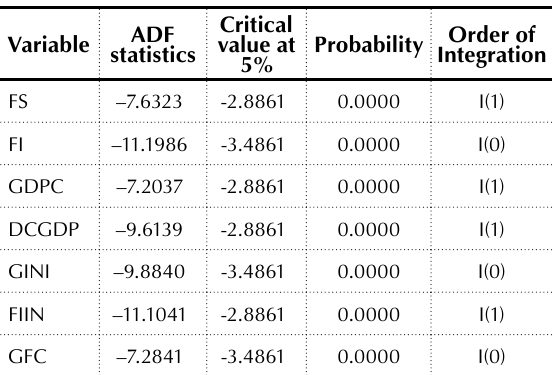
Table 4. Results of unit root test